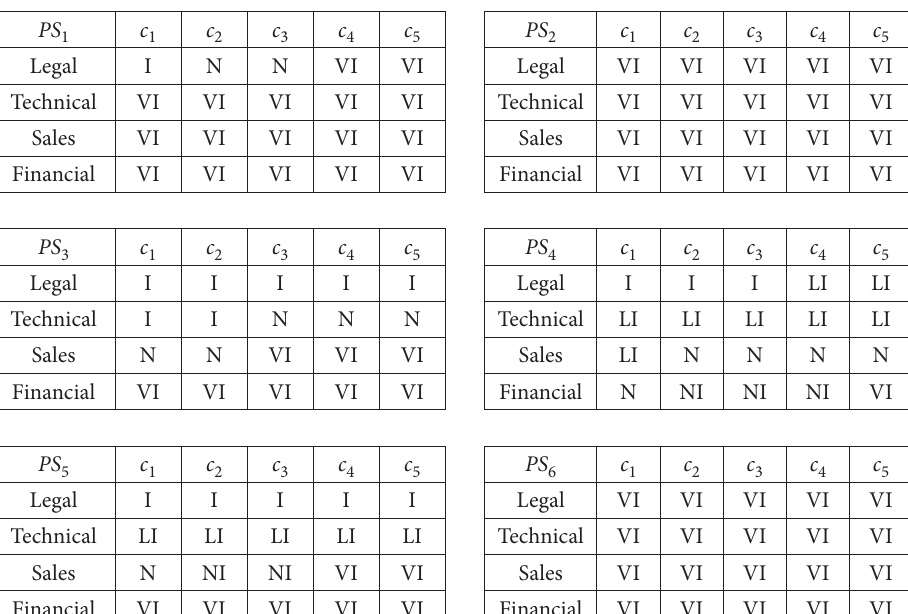
Table 1. Assessments expressed by the expert group I